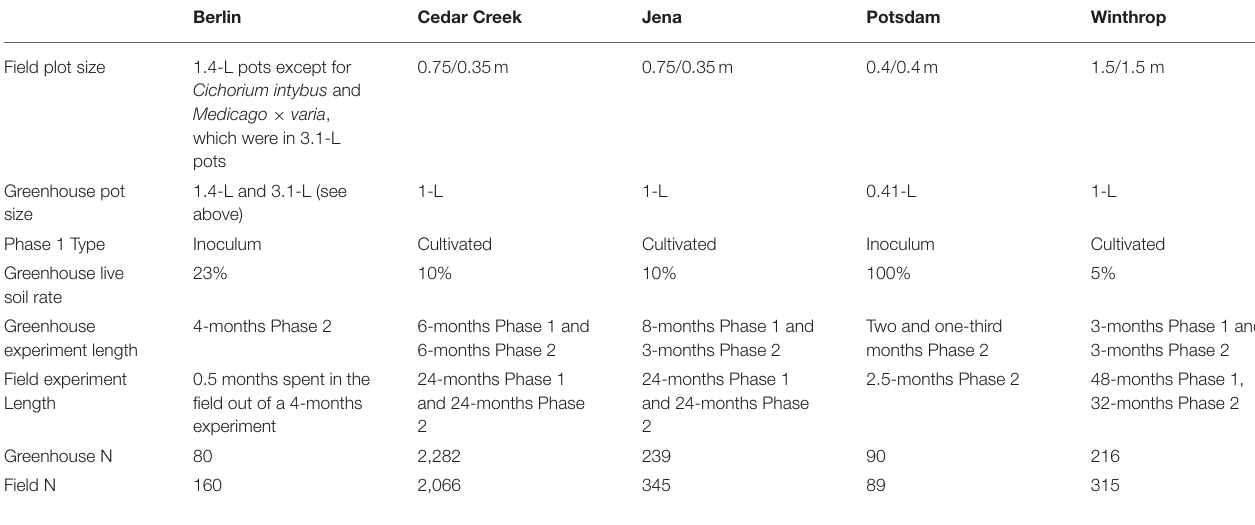
TABLE 1 | Methods for the paired greenhouse and field